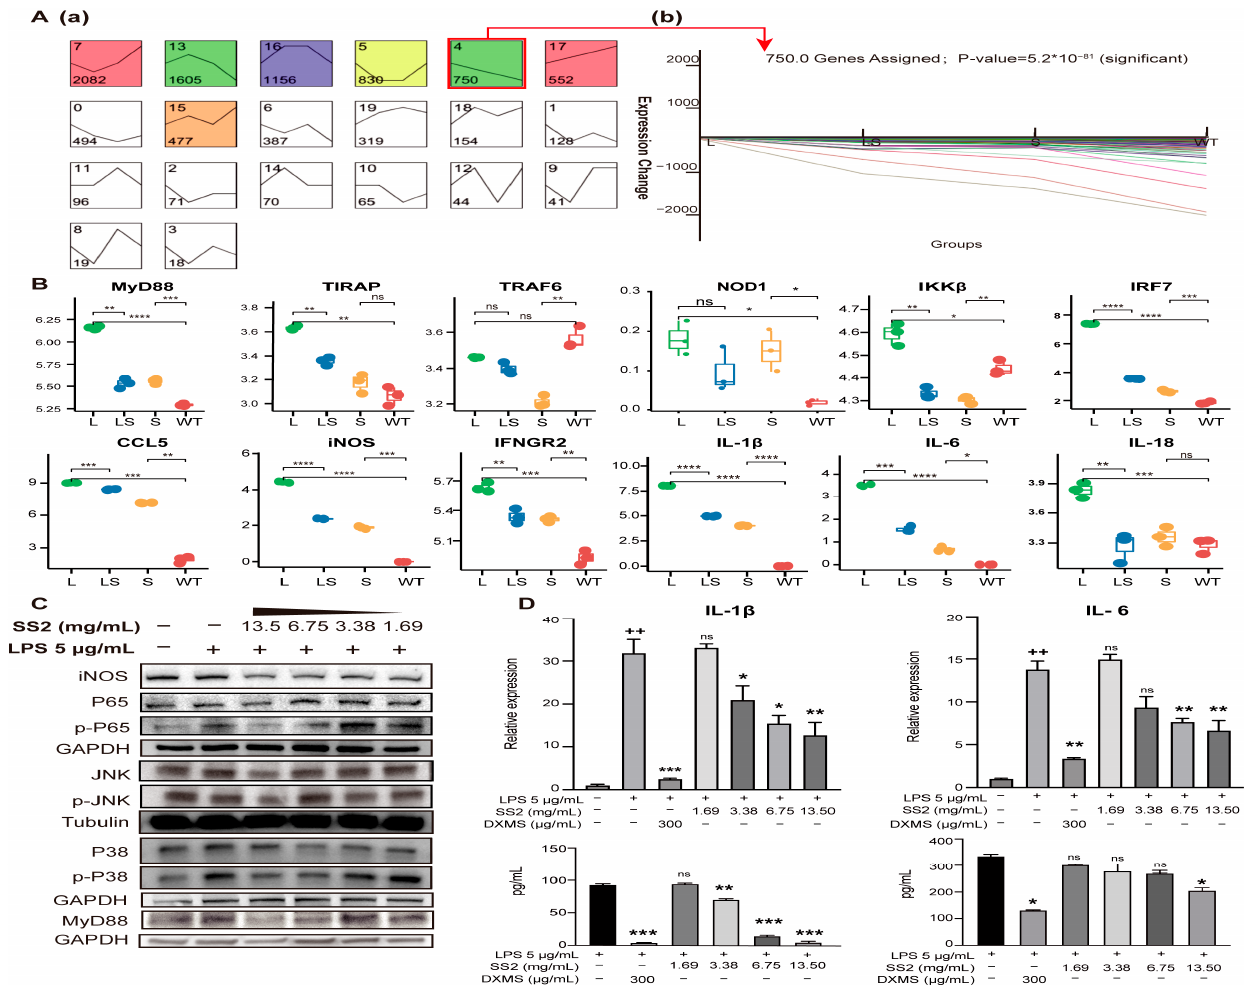
Figure 7. The gene expression tendency of MyD88/NF- κ B signaling pathway. ( A ) Genes that showed the same expression tendency were clustered with the STEM cluster method. Profiles are ordered based on the number of genes assigned. The gene number of every cluster was marked ( a ). Typical gene expression changes details showed at ( b ). ( B ) Examples of genes whose expression was activated by the addition of LPS but repressed by sericin. Comparison of gene expression level among L, LS, S, WT. * p < 0.05, ** p < 0.01, *** p < 0.001, **** p < 0.0001, n = 3. ( C ) The changes in protein abundance of key nodes of the MyD88/NF- κ B signaling pathway when sericin was added into the LPS-infected RAW264.7 cells. ( D ) The ELISA and qRT-PCR reports of IL-1 β and IL-6. + Relative to no-treated cells. * Relative to LPS-treated cells. ++ p < 0.01, * p < 0.05, ** p < 0.01, *** p < 0.001, n =